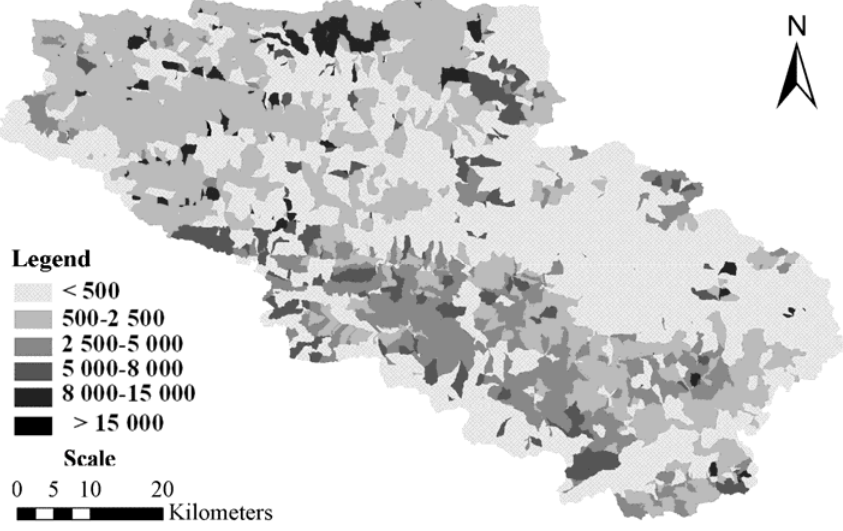
Figure 3. Spatial distribution map of average annual soil erosion by AnnAGNPS in the Daning River